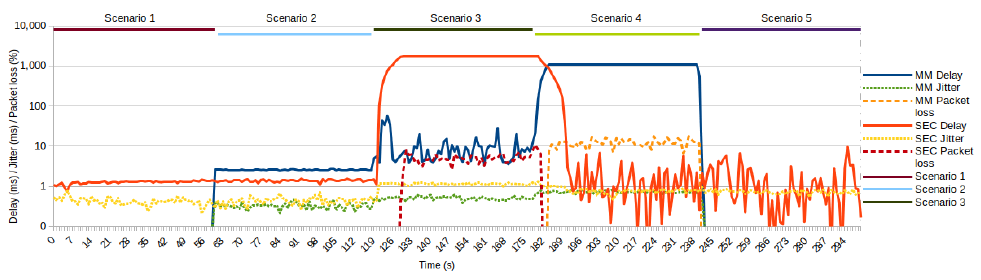
Figure 10. QoS parameters during